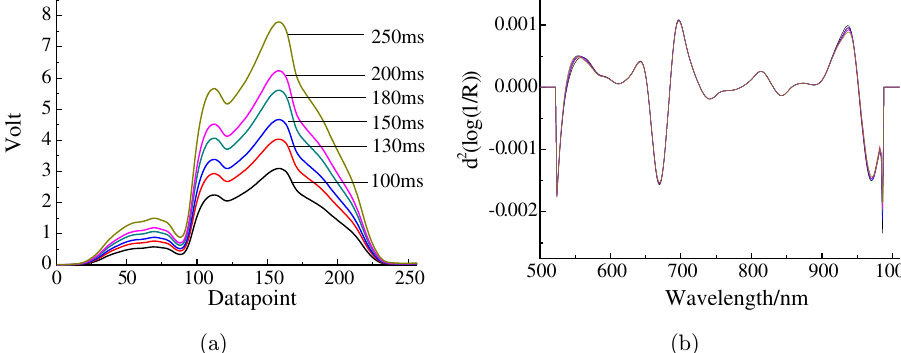
Fig. 4. (a) Energy spectra in di®erent integration times and (b) transfer spectra after second derivative algorithm